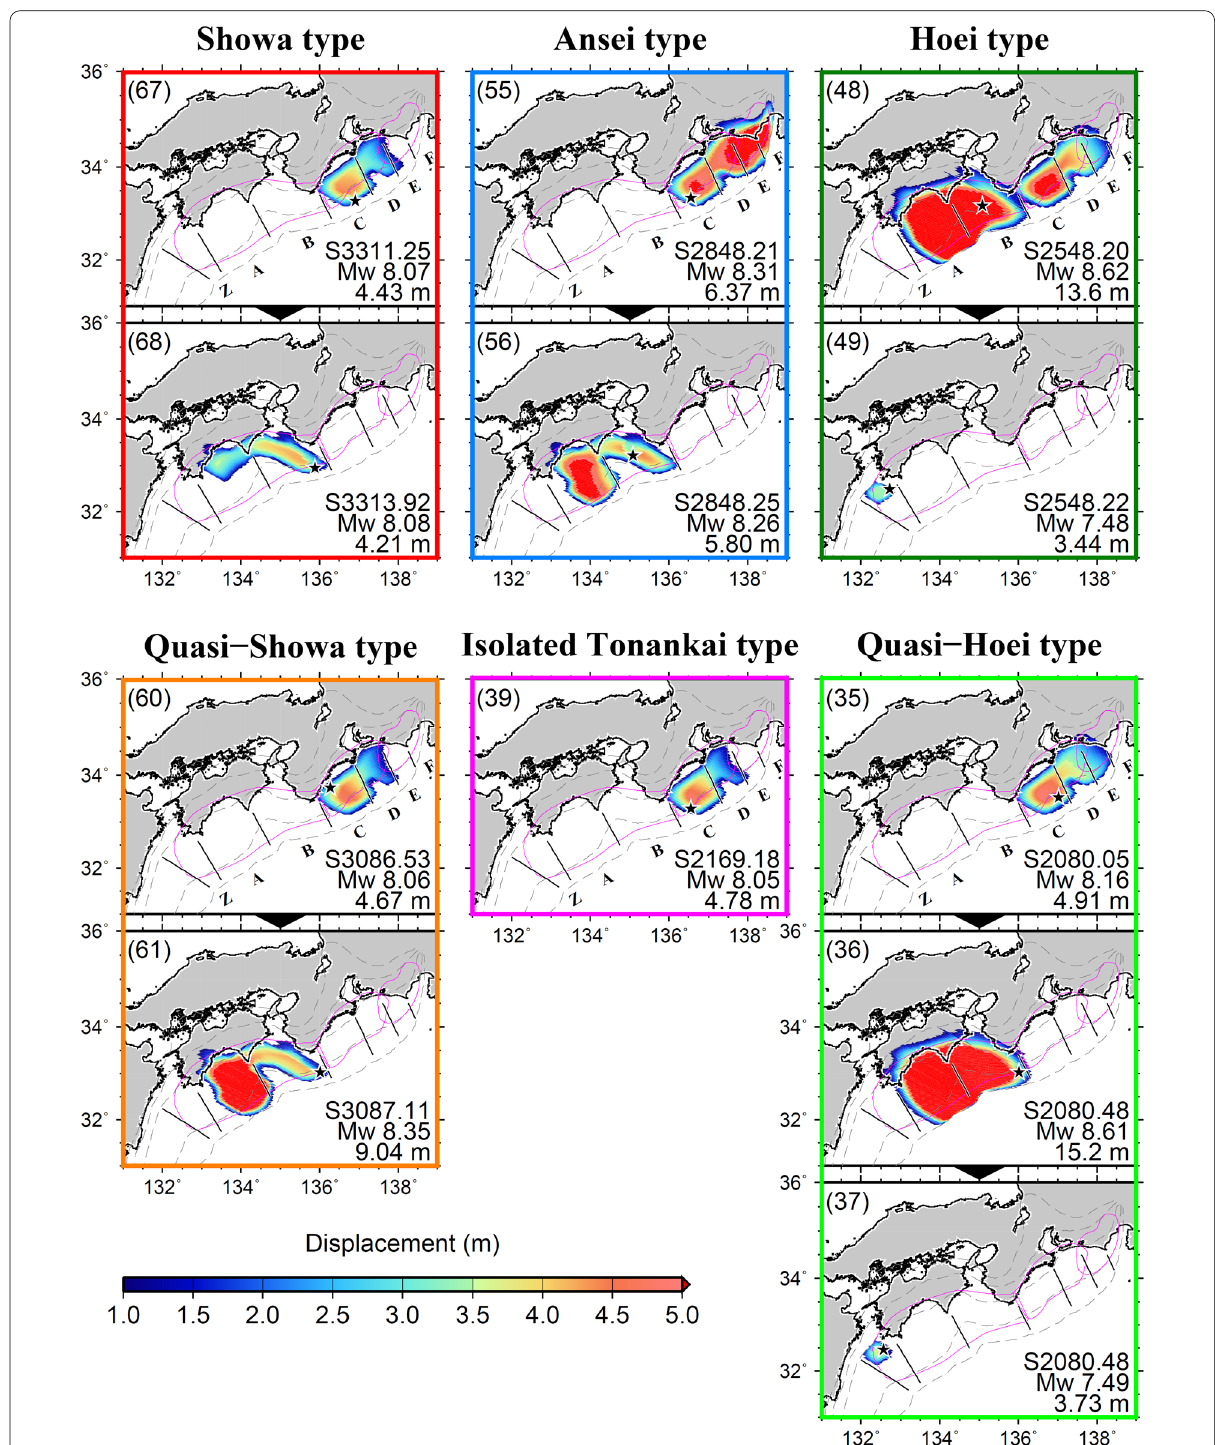
Fig. 5 Examples of slip distribution in six types of earthquake events in our 4400-year simulation. Stars indicate rupture initiation points. In each plot, the event number is at upper left (see Additional file 1: Fig. S2 for all 106 numbered events), and the numbers at lower right are the elapsed years in the simulation (S600–S5000), the moment magnitude, and the maximum slip displacement. Colors of the borders correspond to the event